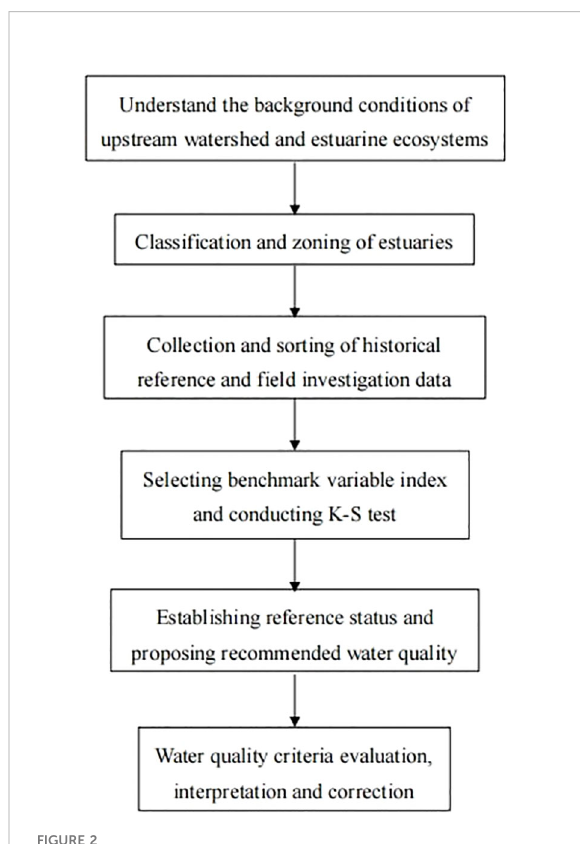
FIGURE 2 Framework of establishing water quality criteria in the PRE coastal water (Li et al.,